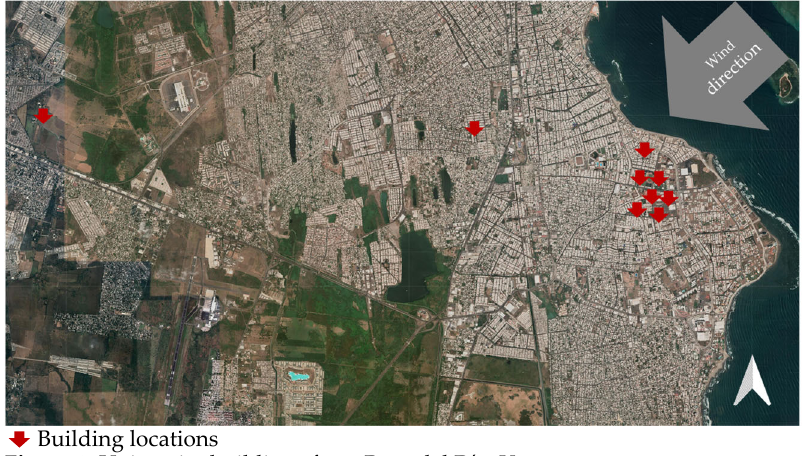
Figure 3. University buildings from Boca del Río, Veracruz.